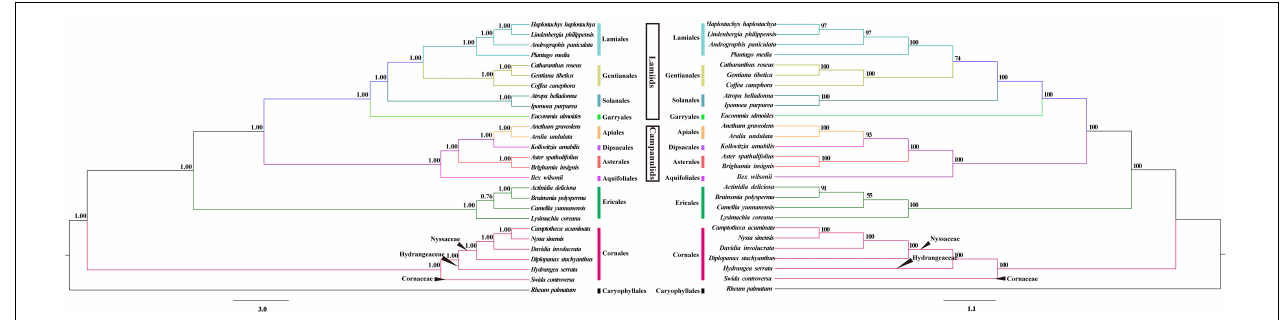
FIGURE 4 | The Bayesian inference (BI, left ) and maximum-likelihood (ML, right ) trees of 26 taxa reconstructed using 73 chloroplast protein-coding genes. Numbers indicate the posterior probabilities from the BI analyses and bootstrap values from the ML analyses.